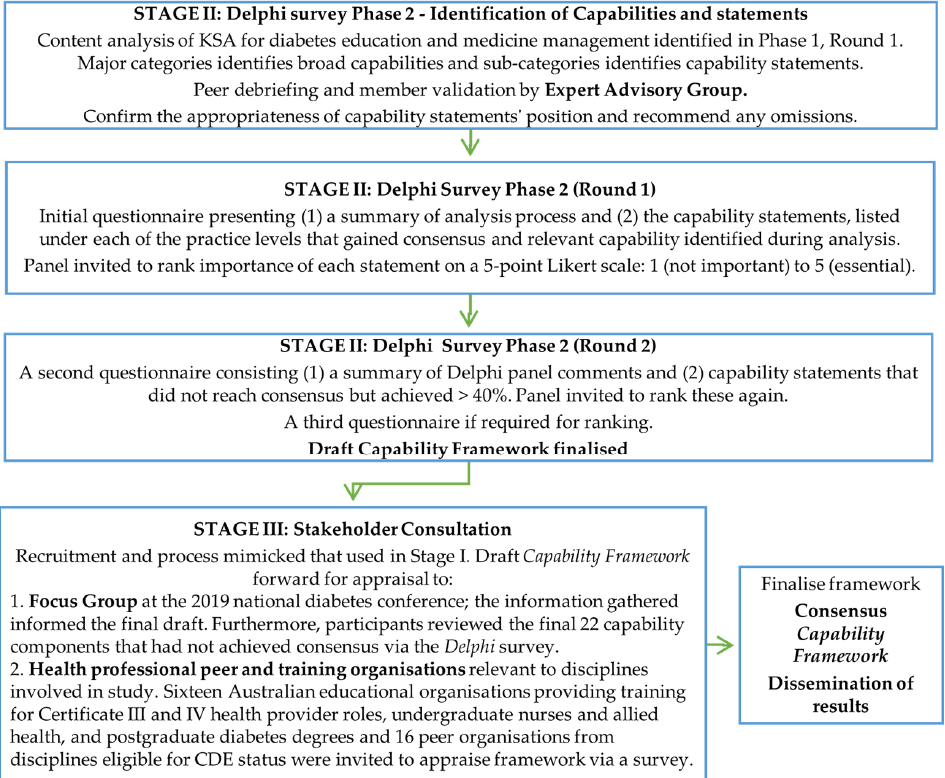
Figure 2. Flow chart guiding chronology of data collection methods .